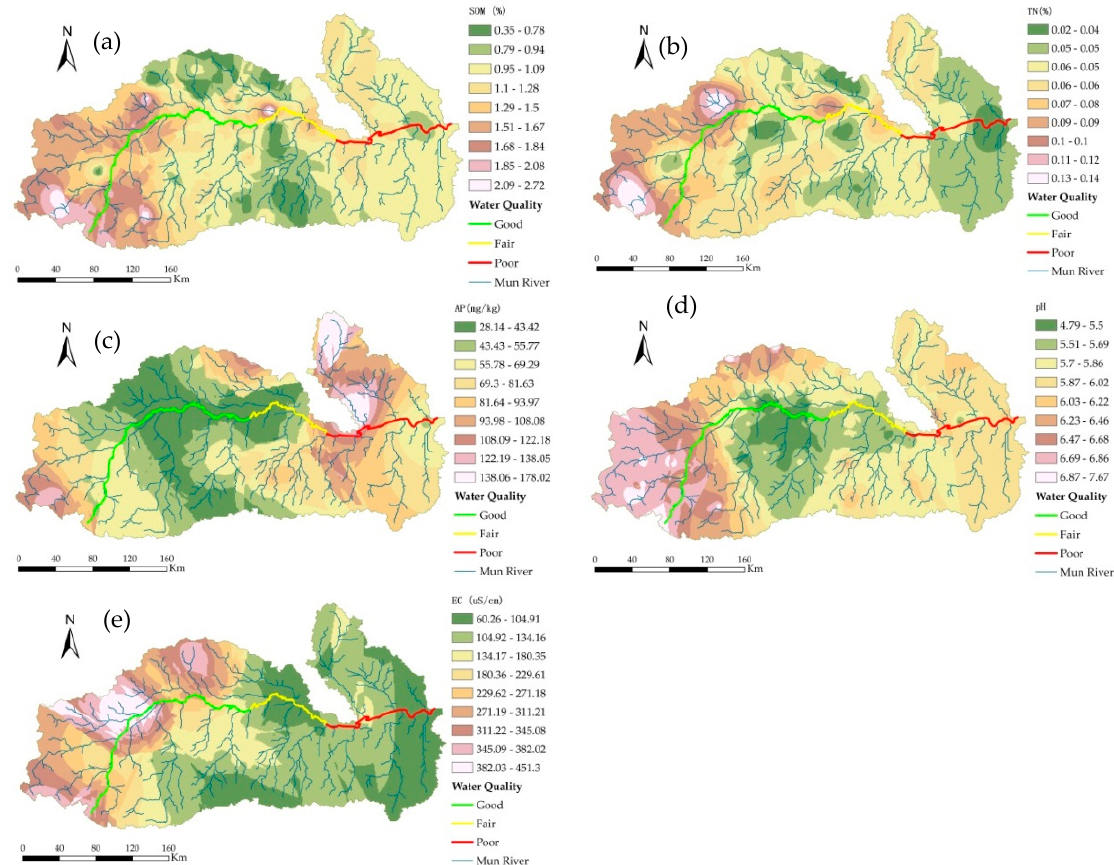
Figure 8. Spatial patterns of ( a ) SOM, ( b ) TN, ( c ) AP, ( d ) pH and ( e ) EC in the dry season.